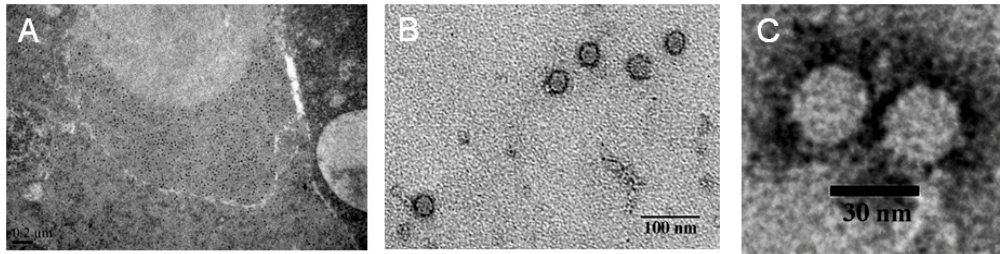
Figure 2. Examination of virus particles by transmission electron microscope (TEM). ( A ) Numerous hexagonal, non-enveloped virus particles observed in the cytoplasm. Bar = 0.2 μ m; ( B ) purified virus particles observed by electron microscopy. Bar = 100 nm; and ( C ) higher magnification of purified virus particle indicated in ( B ). Bar = 30 nm.